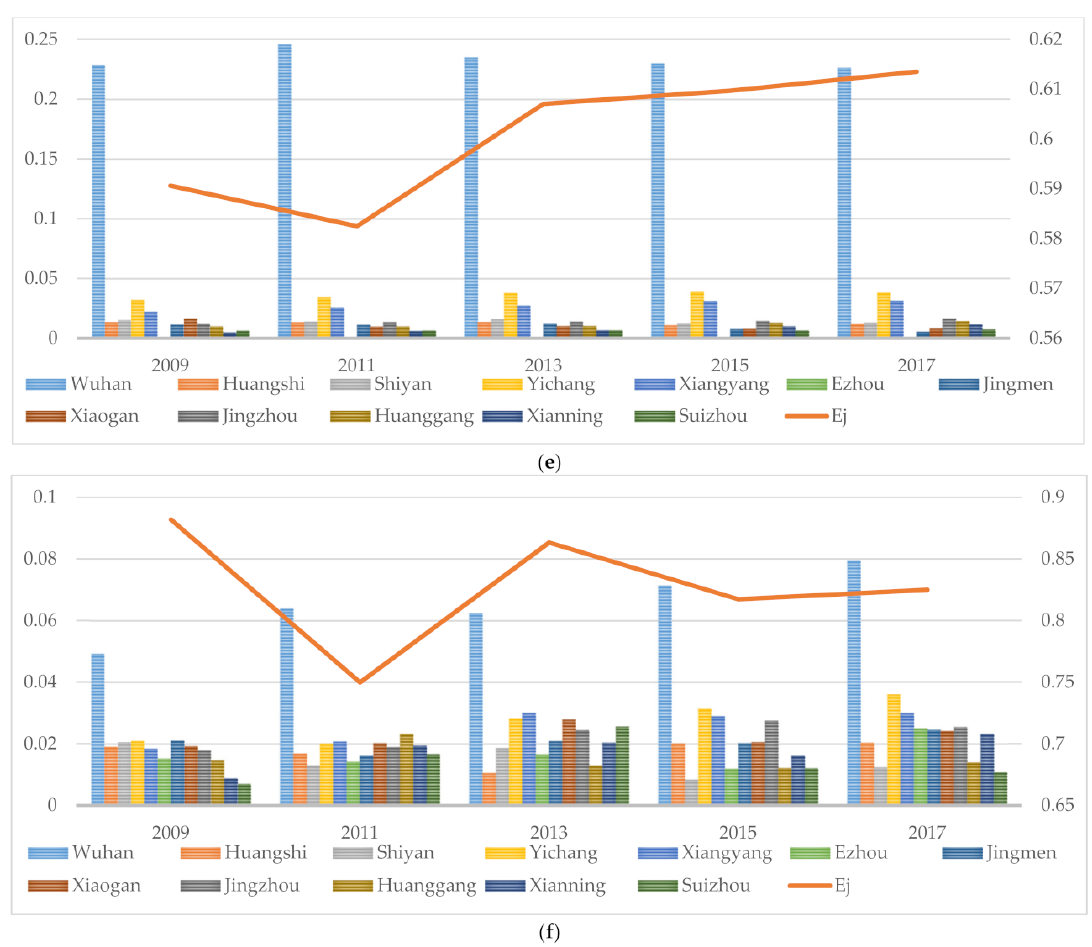
Figure 4. The information entropy and city score of first-level indicators. (The vertical axis on the left is the score, while that on the right is information entropy). ( a ) Population index information entropy and city competitiveness score; ( b ) Economic strength index information entropy and city competitiveness score; ( c ) Infrastructure index information entropy and city competitiveness score; ( d ) Science, technology and culture index information entropy and city competitiveness score; ( e ) Open communication index information entropy and city competitiveness score; ( f ) The quality of life index information entropy and city competitiveness